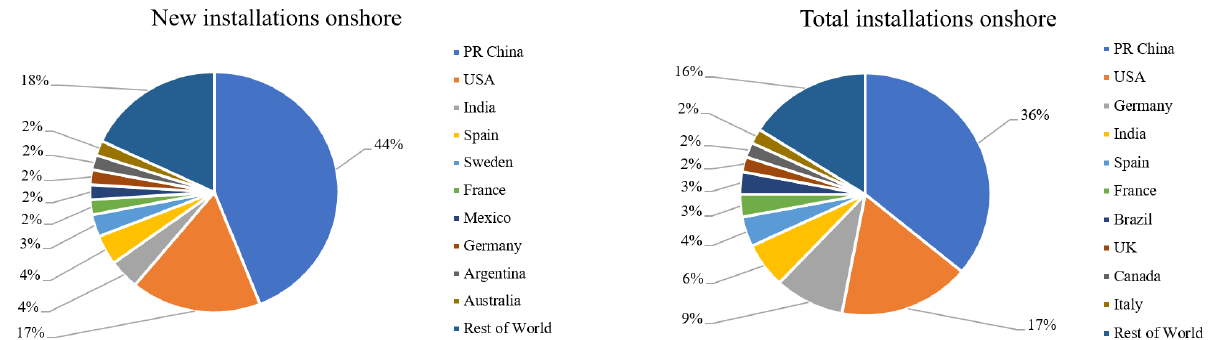
Figure 2. Top ten new installed capacity and cumulative installed capacity by onshore in 2019.